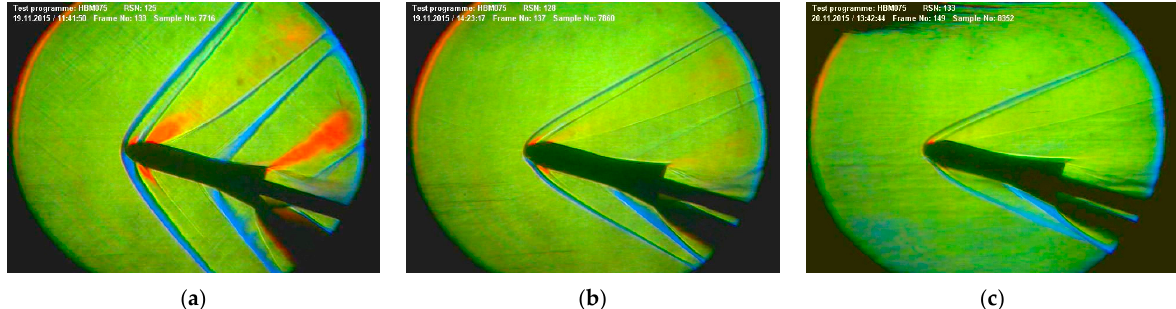
Figure 16. Snapshots from schlieren-visualization video monitoring of tests of the 75 mm HB-2 model: ( a ) Mach 1.5, ( b ) Mach 2.5, ( c ) Mach 3.5, 20 ° angle of attack.